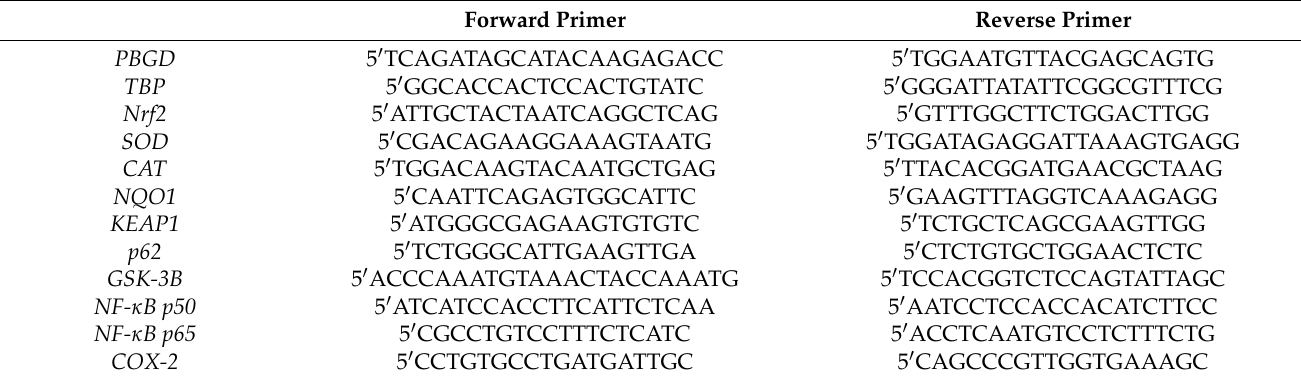
Table 2. The sequence of primers used in